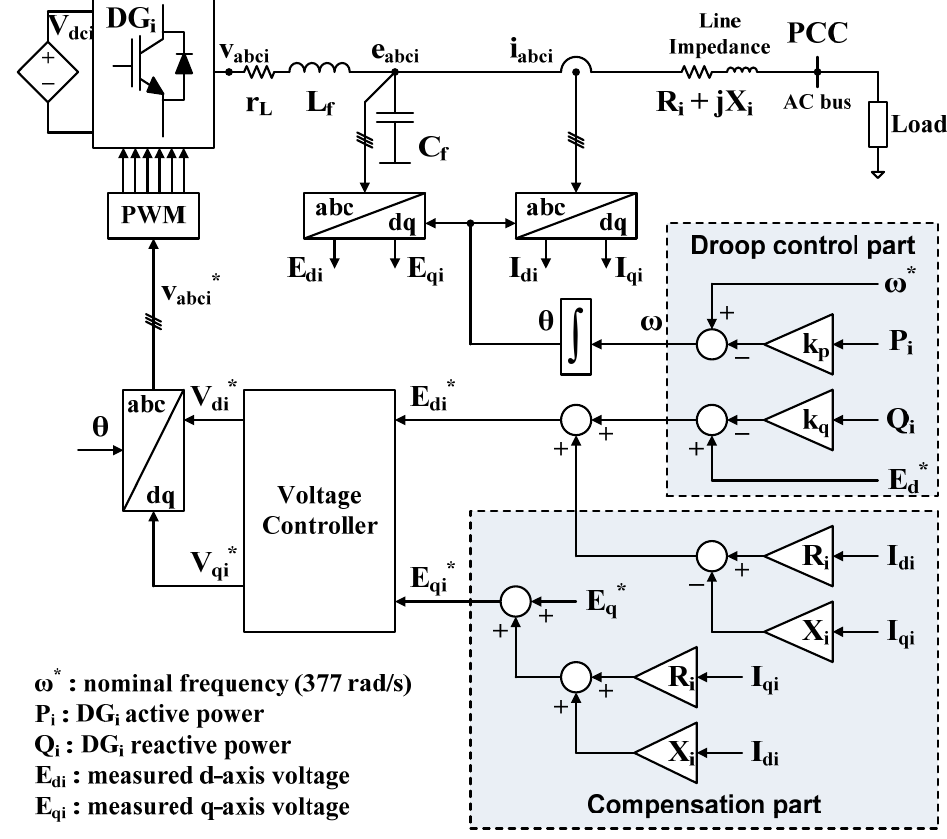
Figure 13. Entire structure of proposed droop control.